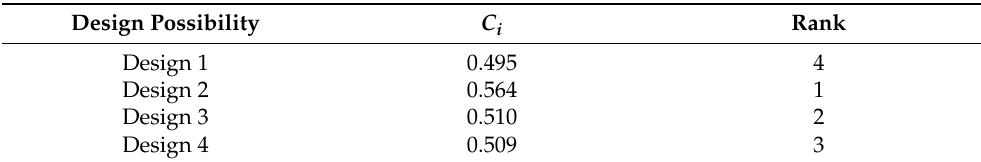
Table 7. Ranking of the design possibility.